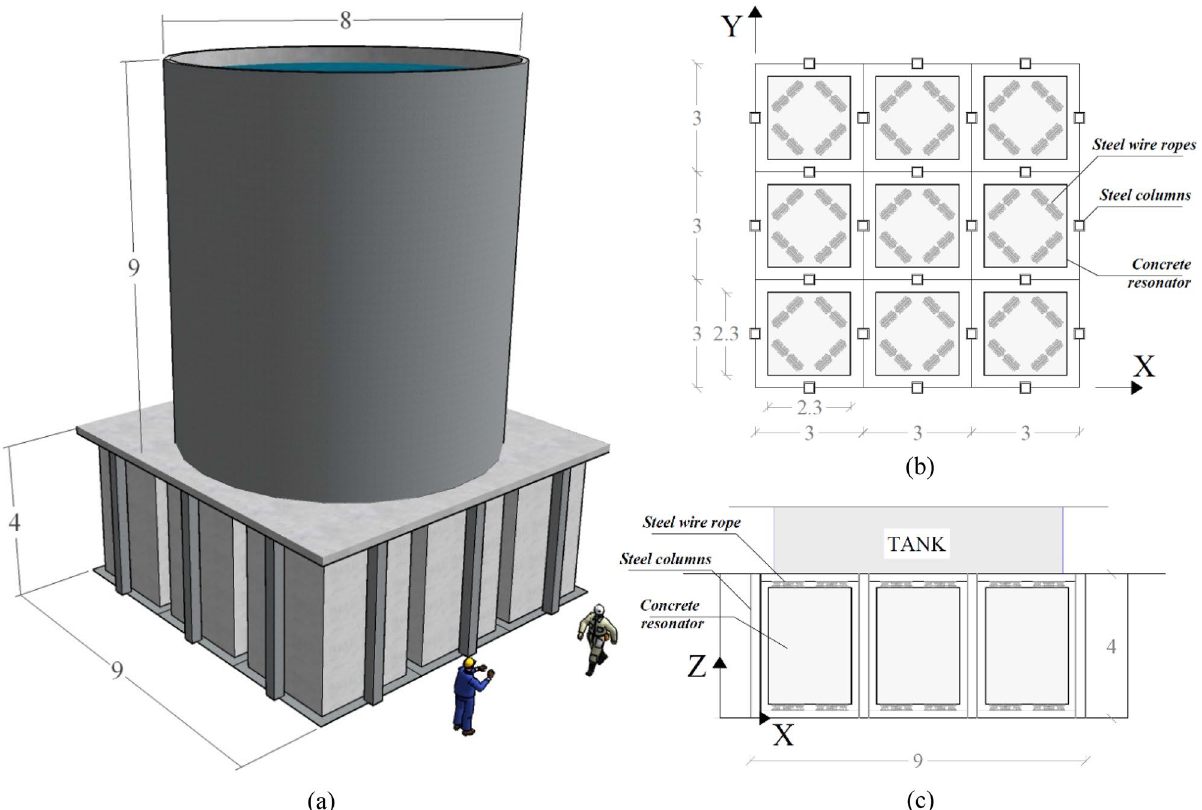
Figure 1. Coupled foundation—tank system: ( a ) 3D view, ( b ) layout of the unit cells and ( c ) cross section of the metafoundation. Dimensions are in m.